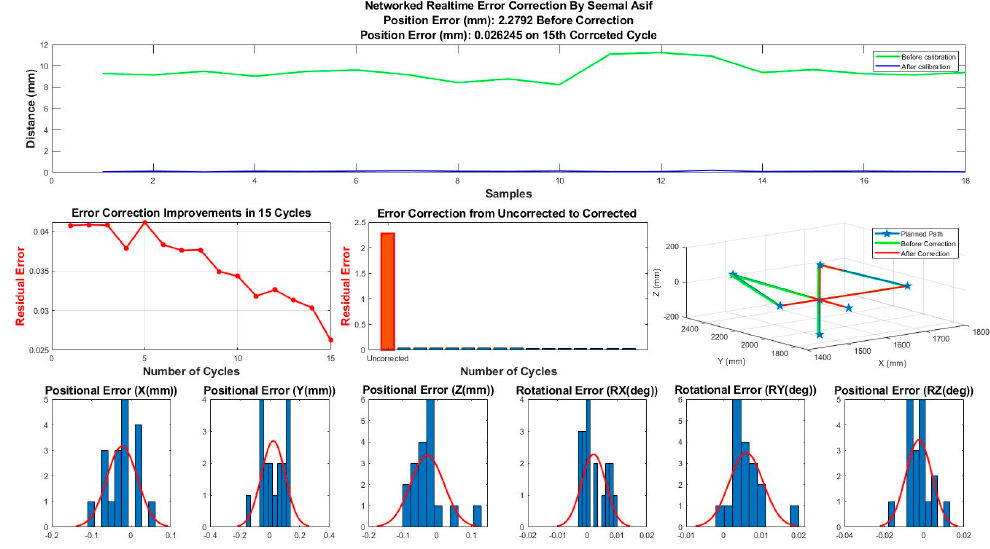
Figure 10. Output of the NRTEC system.